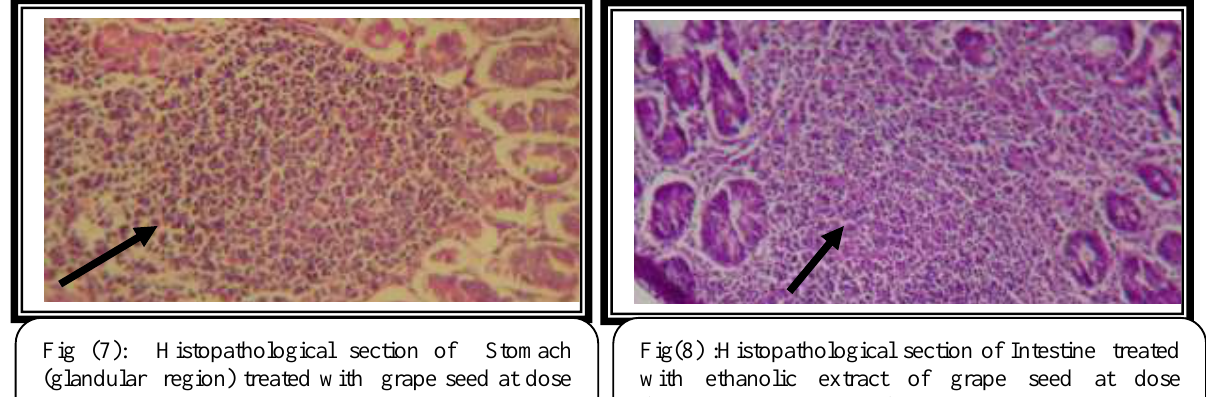
Fig (7): Histopathological section of Stomach (glandular region) treated with grape seed at dose (100mg/kg B.W orally) showing focal aggregation of mononuclear cells in mucosa (H&E x400).